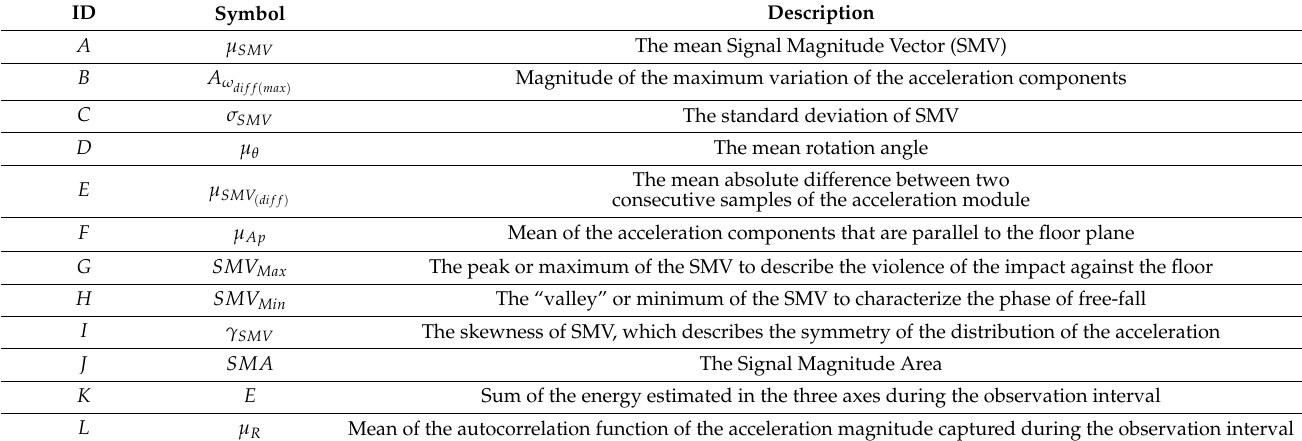
Table 5. Values and alternatives of statistics analyzed to select the input feature set of the